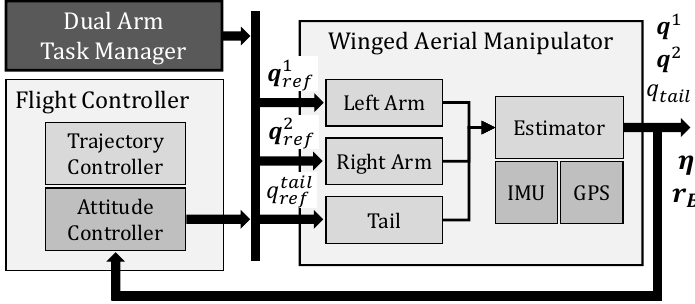
Figure 8. General control scheme of the winged aerial manipulator.